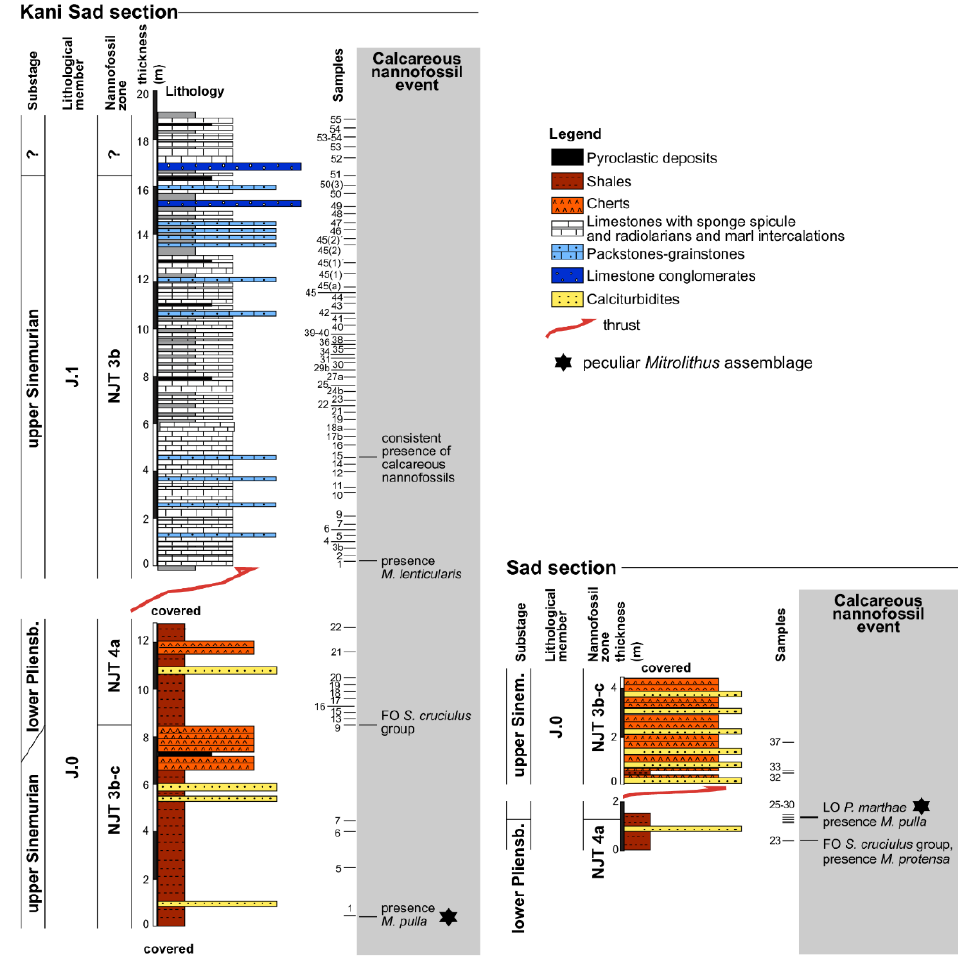
Figure 2. Stratigraphic logs of the Kani Sad and Sad sections, indicating the position of nannofossil samples (partly modified after Abdi et al. [1,23,24]). The first occurrence (FO) of the S. cruciulus group is reported, as Similiscutum cruciulus , Similiscutum orbiculus and Similiscutum avitum likely represent different ecophenotypes of the same species (Mattioli et al. [29]). Note that, according to nannofossil biostratigraphy, the J.0 member of the Kani Sad and Sad sections is younger than the J.1 member. The shaly units of the J.0 member of the Kani Sad and Sad sections are part of two limbs of a syncline structure, which is over-thrusted by the siliceous mudstones and grainstones of the J.1 member. The lower part of the Sad section is stratigraphically reversed, as also shown by the position of nannofossil zones.